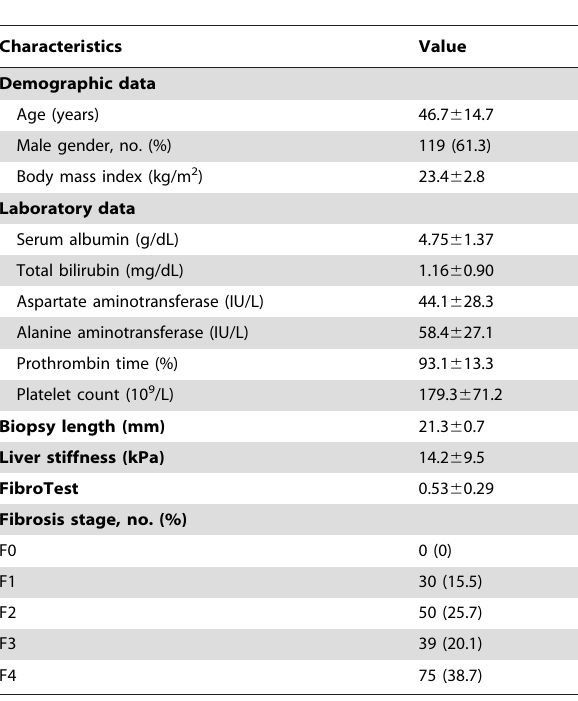
Table 1. Baseline characteristics (n